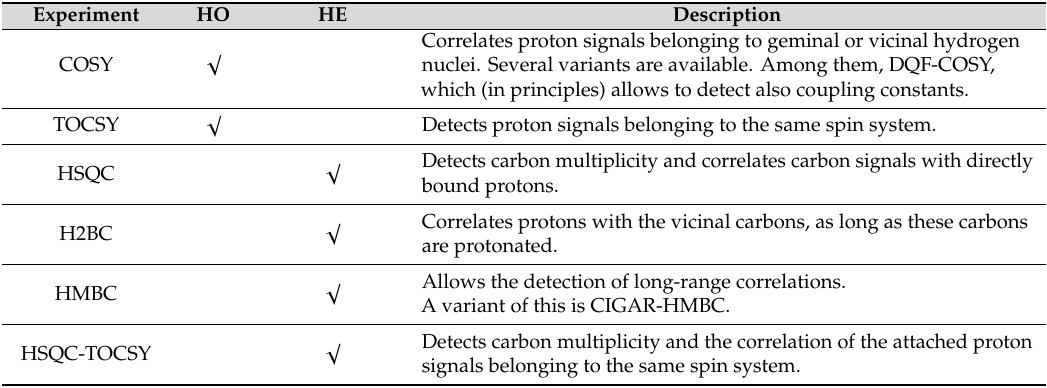
Table 1. Commonly used 2D-NMR (Nuclear Magnetic Resonance Spectroscopy) experiments.